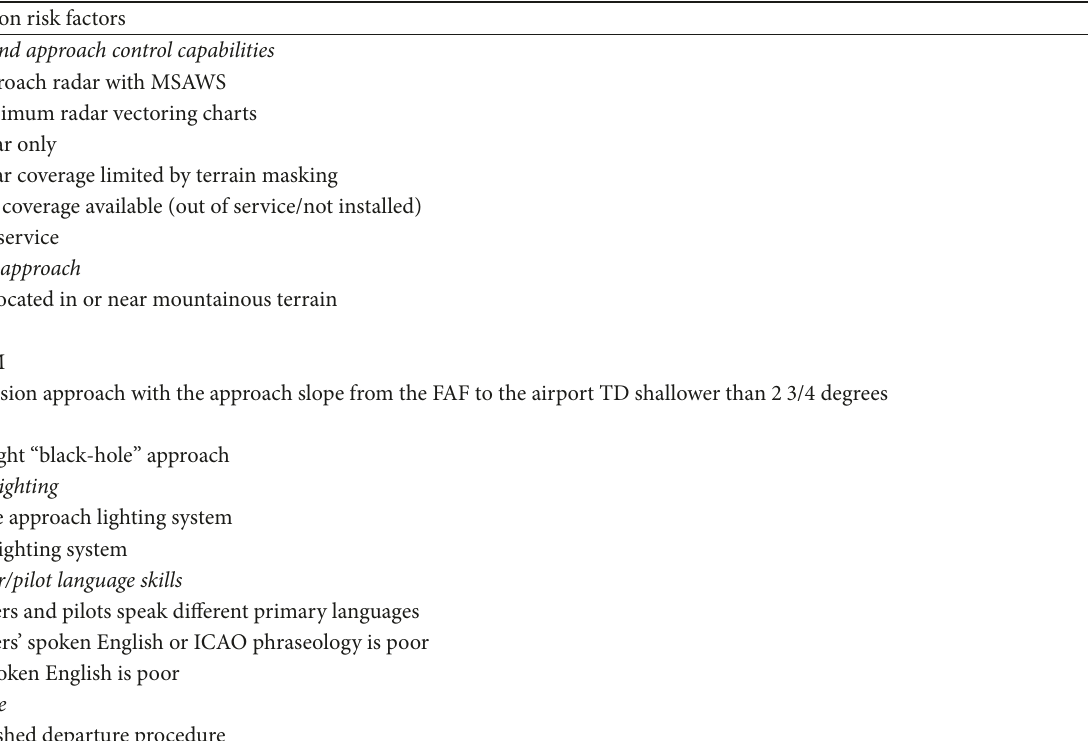
Table 2: Risk assessment